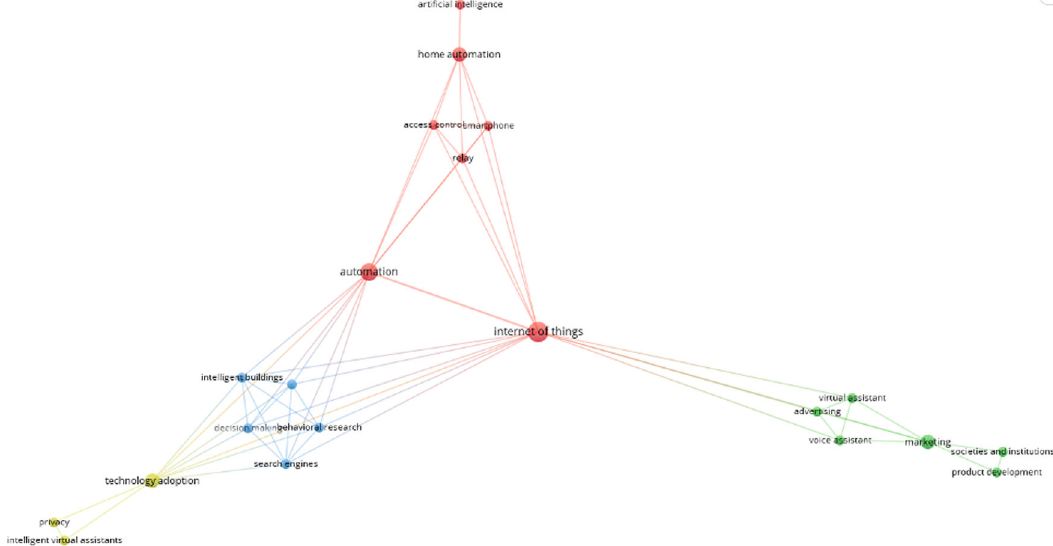
Fig. 5 Co-occurrence network for the BMS- fi eld. The frequently co-occurring keywords, topics, or themes in research in the BMS fi eld on VAs in private households. Table 4 Distribution of articles in the fi nal